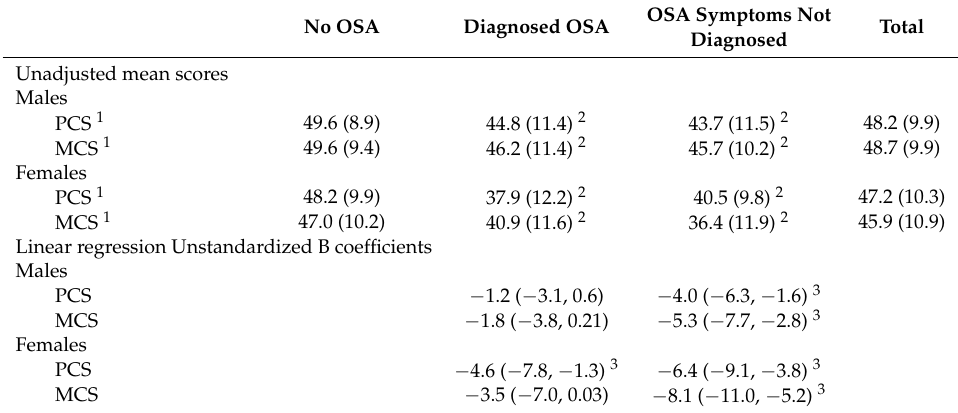
Table 4. Unadjusted mean (SD) physical component summary (PCS) and mental component summary (MCS) scores and age- and BMI-adjusted coefficients for the association of OSA status with PCS and MCS